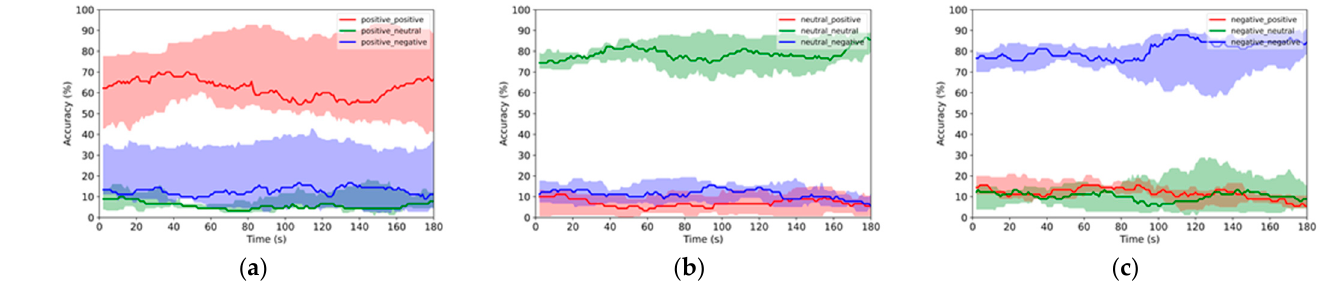
Figure 5. Online emotion recognition results when using DE features: ( a ) online recognition of positive emotion samples; ( b ) online recognition of neutral emotion samples; ( c ) online recognition of negative emotion samples.